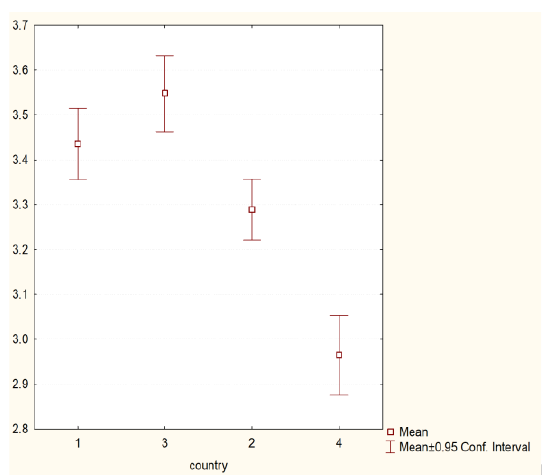
Figure 1. Preventive behaviours and country of origin (H = 98.43755 p = 0.000). Legend: 1 — Poland, 2 — Hungary, 3 — Greece, 4 — Turkey.